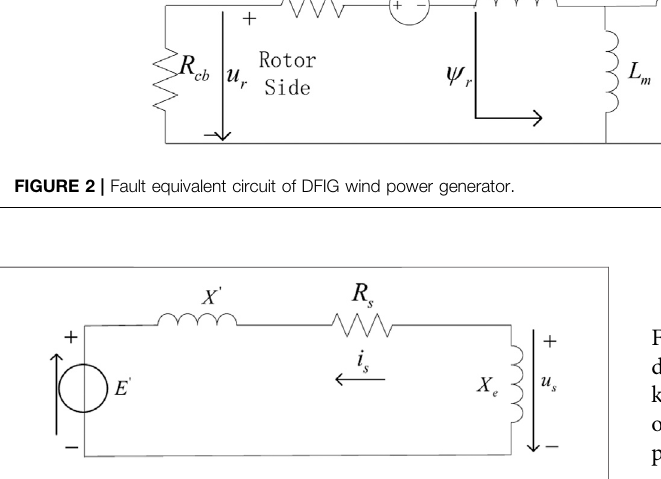
FIGURE 3 | Simpli fi ed equivalent circuit of DFIG.